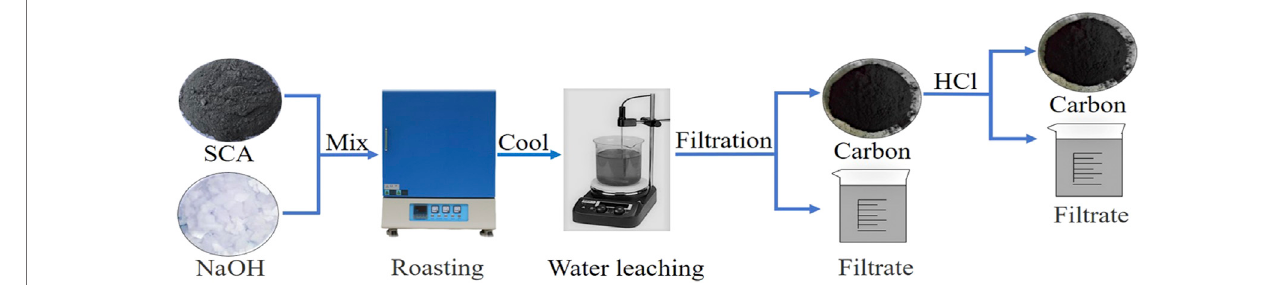
FIGURE 7 | SCA treatment via NaOH alkali fusion.